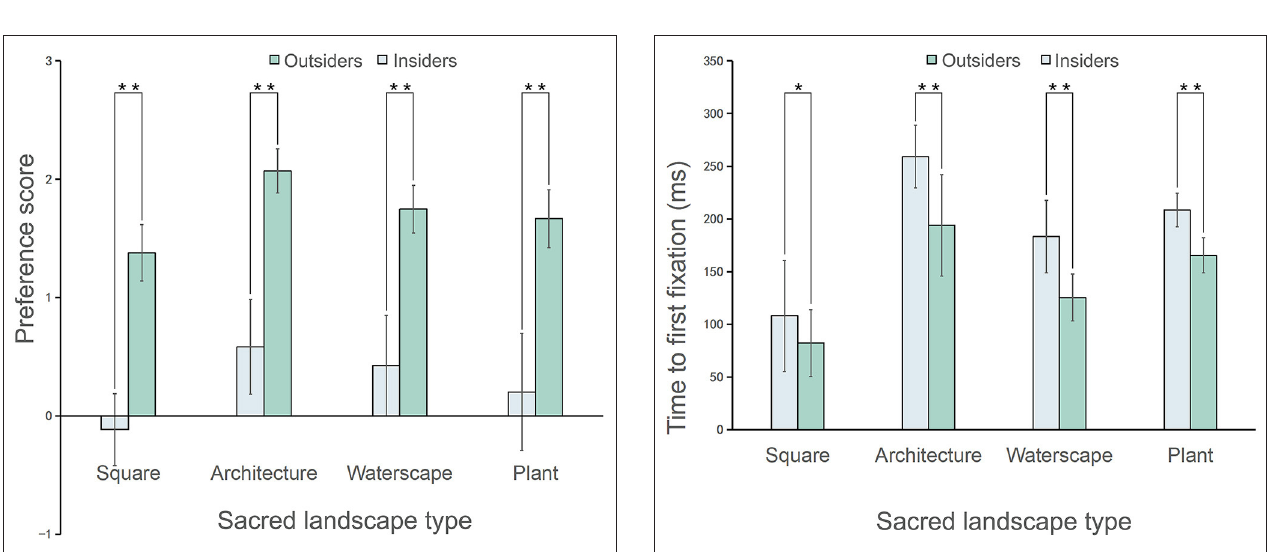
FIGURE 4 | Comparison of the time to first fixation between the outsiders and insiders (* p < 0.05, ** p < 0.01); the data are shown as means (SD). N = 45 for each